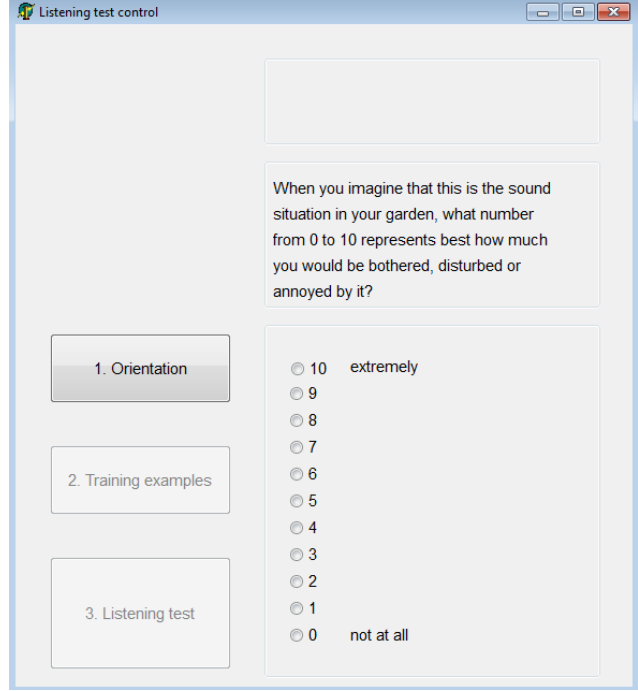
Figure 2. Experimental software’s graphical user interface